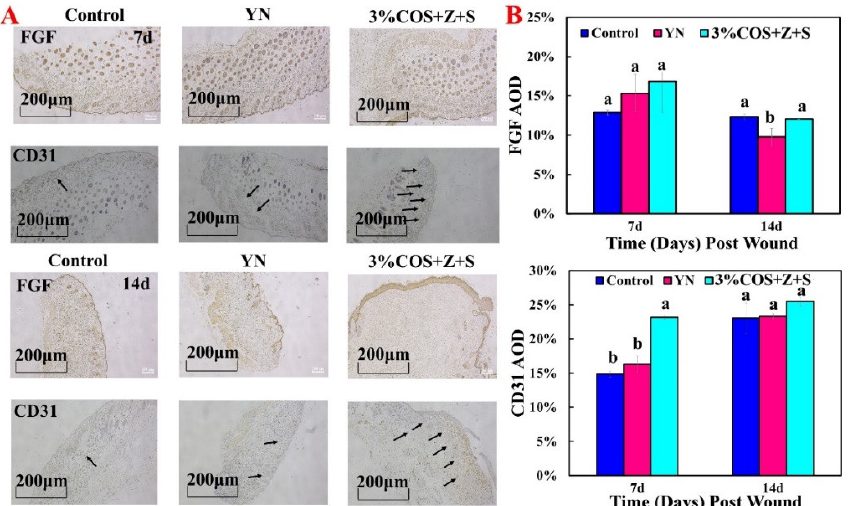
Figure 6. Expression of FGF and CD31 of nIon 2+ −COS/SA gel films in mice. ( A ) From top to bottom, representative images of FGF and CD31 analysis on day 7; representative images of FGF and CD31 analysis on day 14. The black arrow indicated the expression of CD31. ( B ) Quantitative immunohistochemical analysis on day 7 and day 14. Note: Same superscript letters indicate non−significant differences ( p > 0.05), different superscript letters indicate significant differences ( p < 0.05).